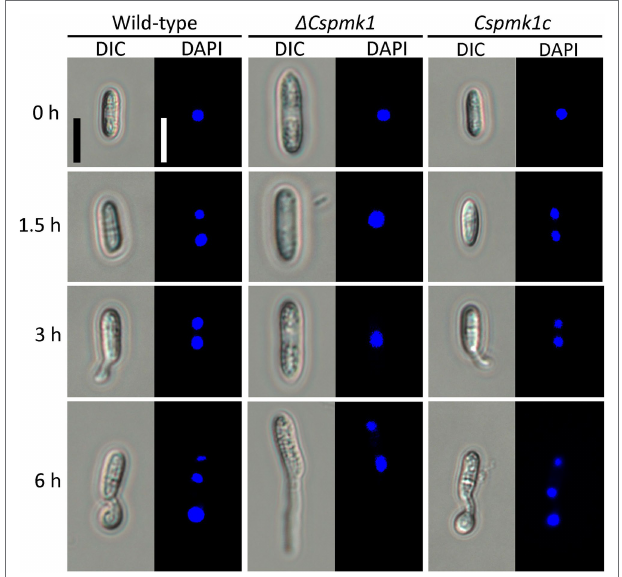
FIGURE 4 | CsPMK1 is involved in nuclear division. Conidial suspensions (5 × 10 4 ml − 1 ) were placed on the hydrophobic surface of coverslips and incubated at 25 ° C. The 4 ′ ,6-Diamidino-2-phenylindole (DAPI) was used to stain nuclei in developing conidia. Scale bar, 10 μ m. FIGURE 5 | CsPMK1 is related to lipid mobilization. Conidial suspensions